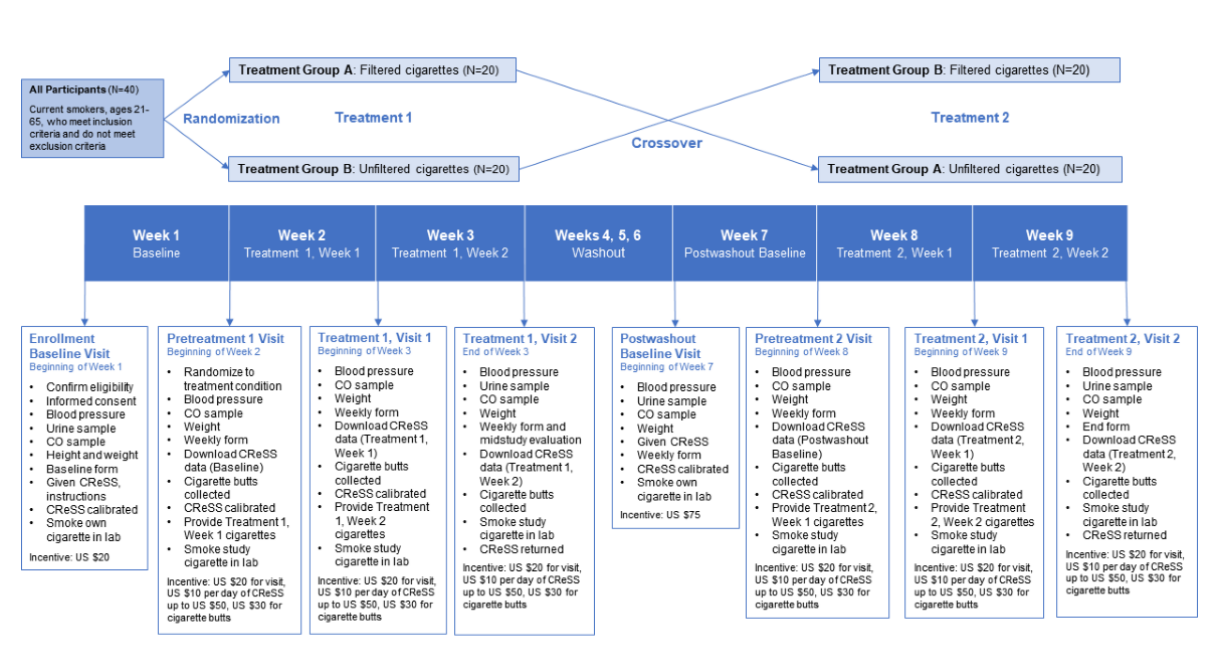
Figure 1. Study design diagram of the randomized crossover clinical trial of unfiltered cigarettes. CO: carbon monoxide; CReSS: Clinical Research Support